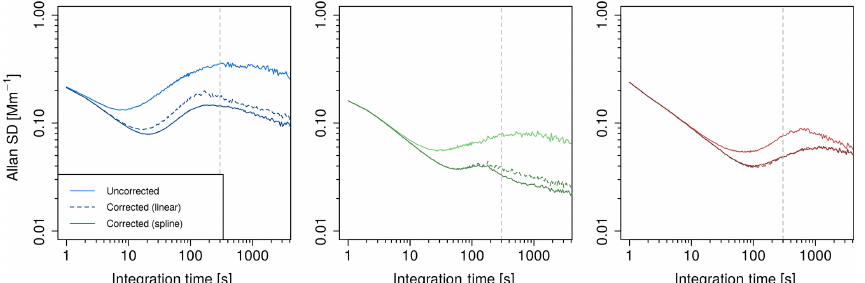
Figure 5. Secondary Allan standard deviation plots of extinction coefficients (450, 530 and 630nm) for particle-free ambient air. Vertical dashed lines denote time intervals of baselines